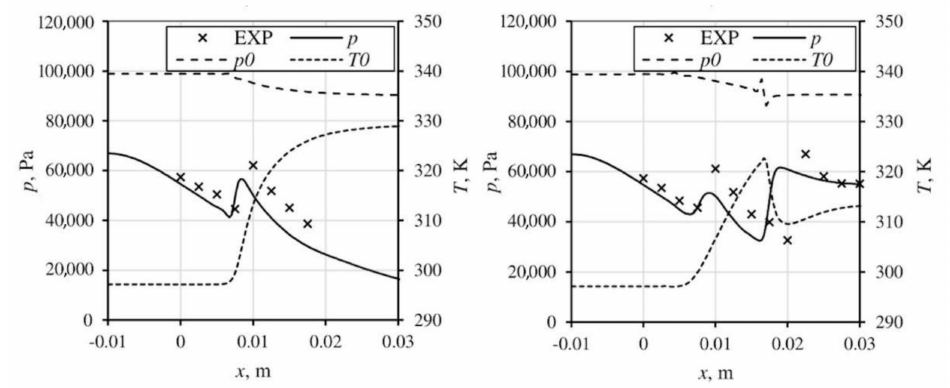
Figure 3. The experimental and numerical results for relative humidity equal to 68% (supersonic outlet—left, back pressure 55 kPa—right).